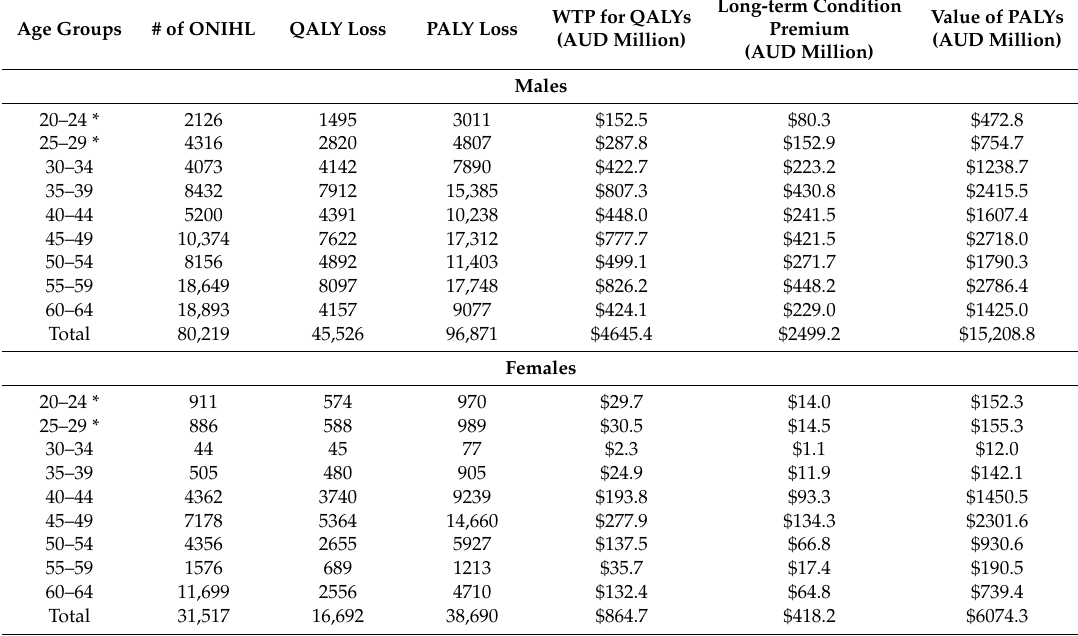
Table 1. The economic burden of occupational noise-induced hearing loss (ONIHL) in Australian working population by age and sex groups.